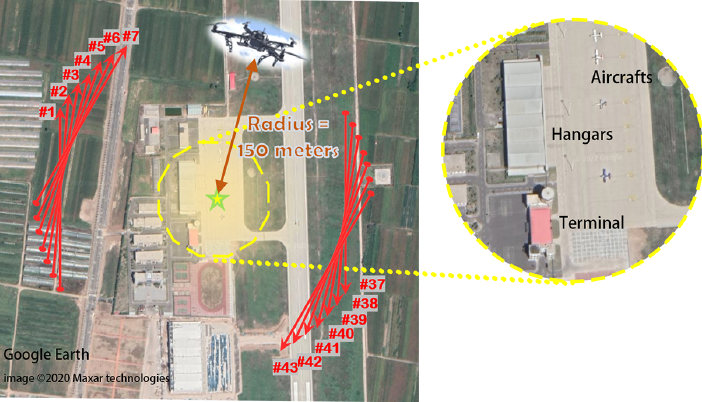
Figure 6. Multi-aspect flight campaign over a domestic airport. Yellow dash circle: spot area with 360° illumination. Red arrow: flight trajectory